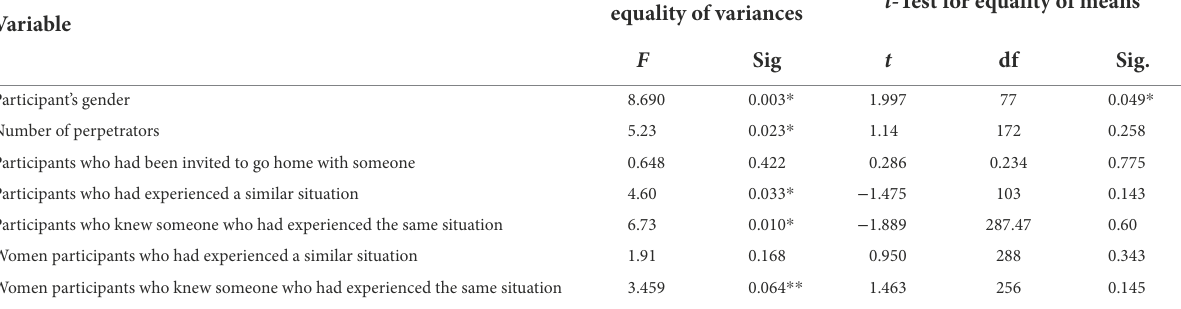
TABLE 2 Attribution of